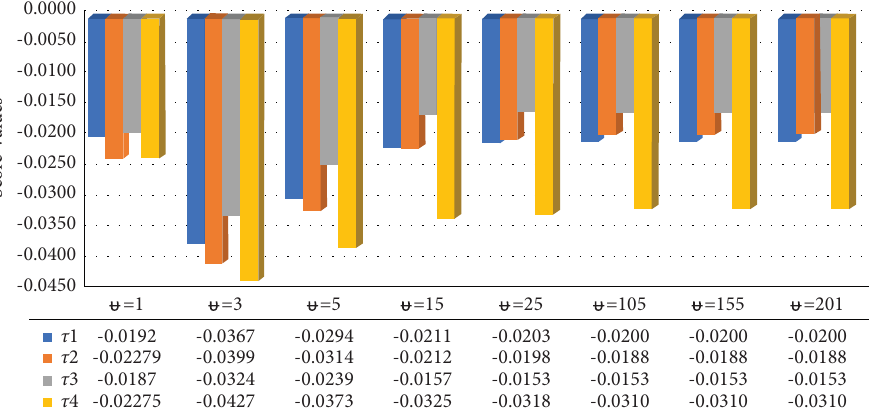
Figure 3: Consequences of the IVPFAAWG operator by the variation in the value of ᵿ . Table 5: Comparison of consequences of existing AOs with current AOs.